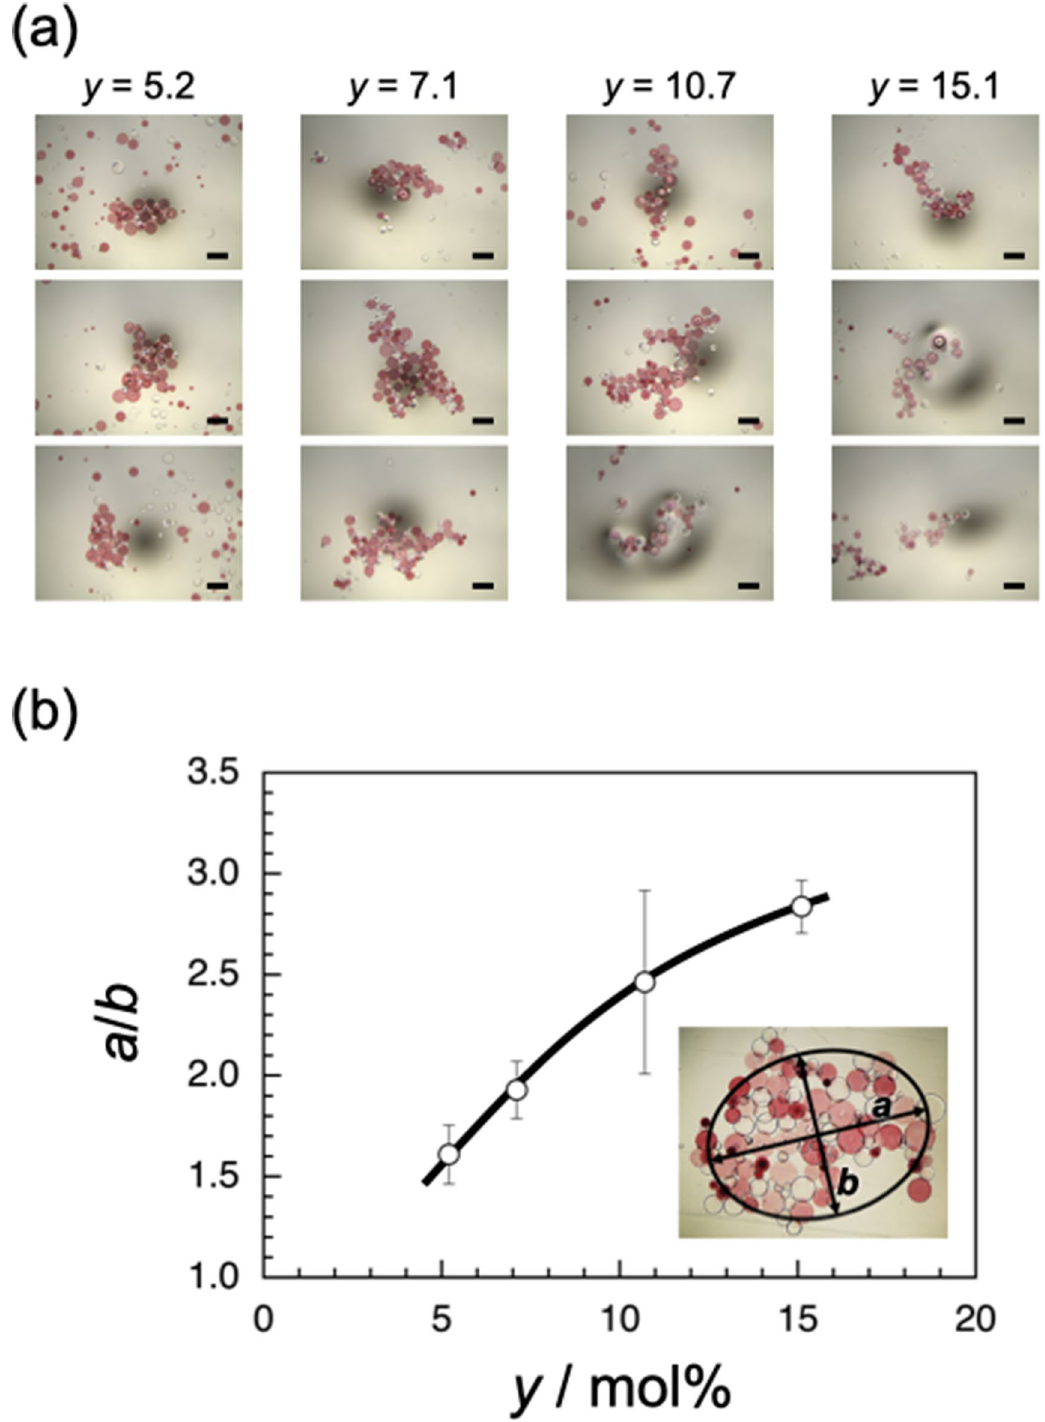
Figure 3. ( a ) Optical micrographs for assemblies formed from βCD(26.7)-SAP and Ad( y )-SAP microparticles of y = 5.2, 7.1, 10.7, and 15.1. The segments indicate 20 μm. ( b ) The aspect ratio, a / b , of assemblies as a function of y , and a typical example of estimation of a / b using an ImageJ software. The inset is an optical micrograph for the assembly formed from βCD(26.7)-SAP and Ad(5.2)-SAP